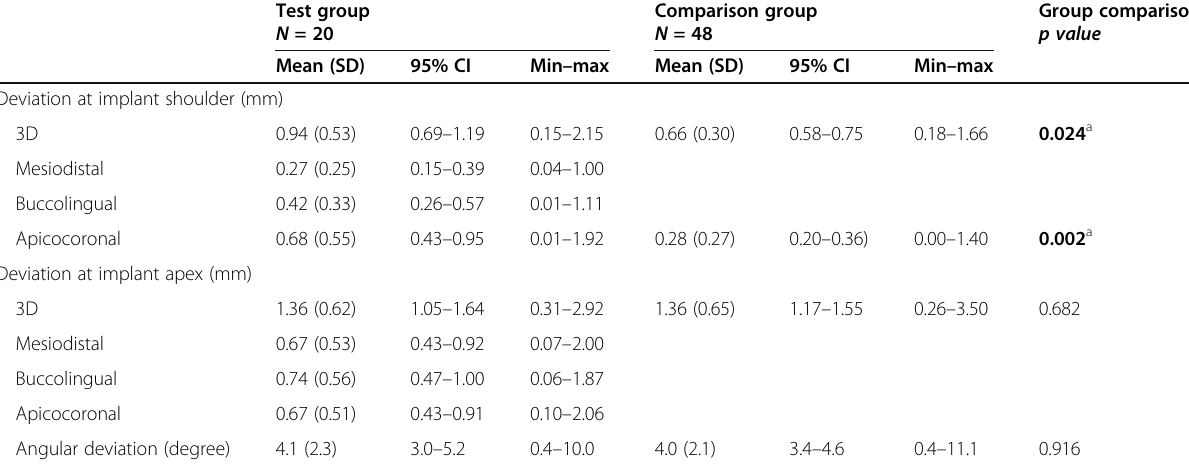
Table 2 Deviations between the planned and actually achieved implant positions